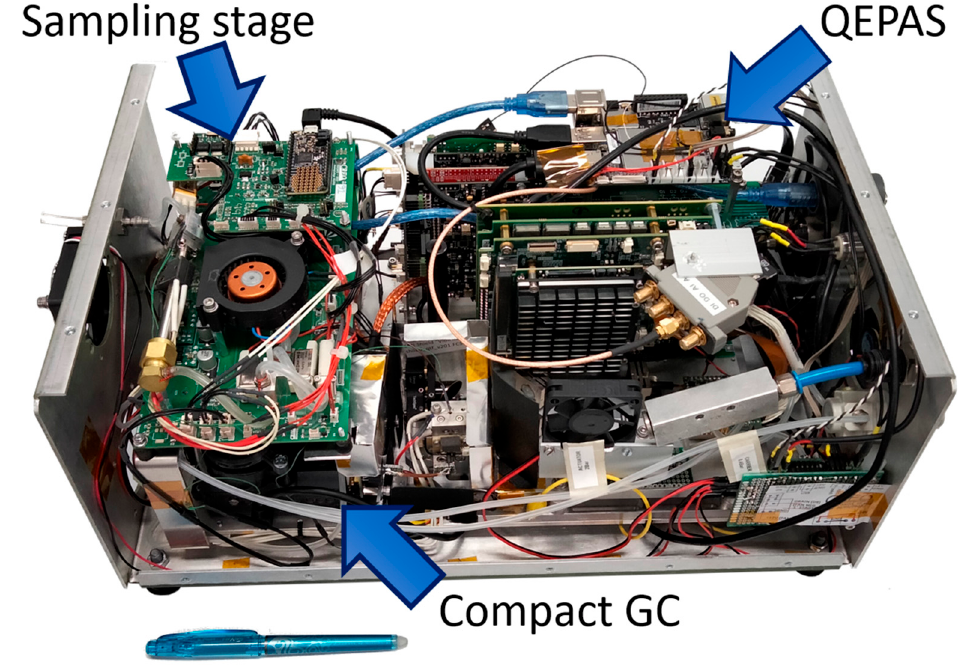
Figure 2. GC-QEPAS sensor assembled for RISEN.